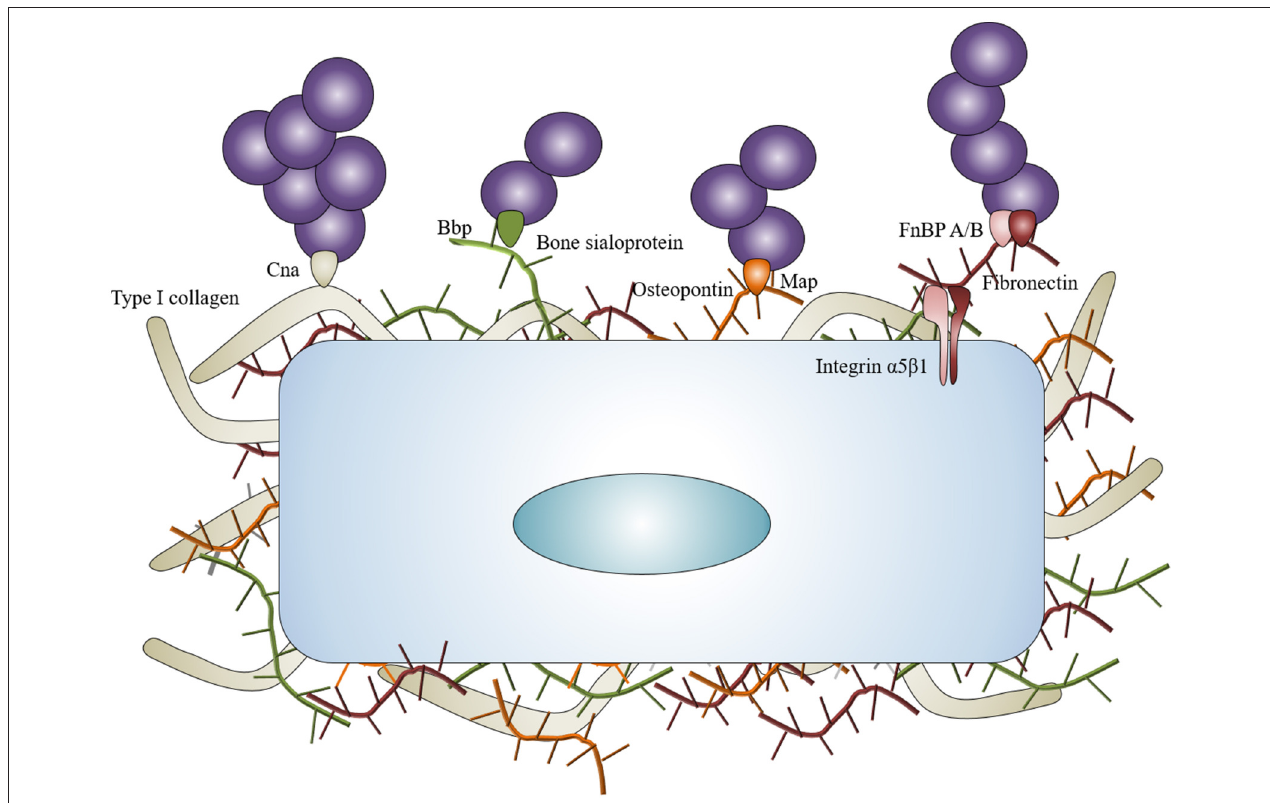
FIGURE 1 | Staphylococcus aureus interaction with BEM. Staphylococcus aureus can interact with the BEM to concentrate around osteoblasts. Collagen adhesin (Cna) links with type I collagen, bone sialoprotein binding protein (Bbp) links with bone sialoprotein, MHC II analog protein (Map) can potentially link osteopontin. Fibronectin binding proteins A and B (FnBP A/B) link with fibronectin and act as bridges between Staphylococcus aureus and osteoblasts through α 5 β 1